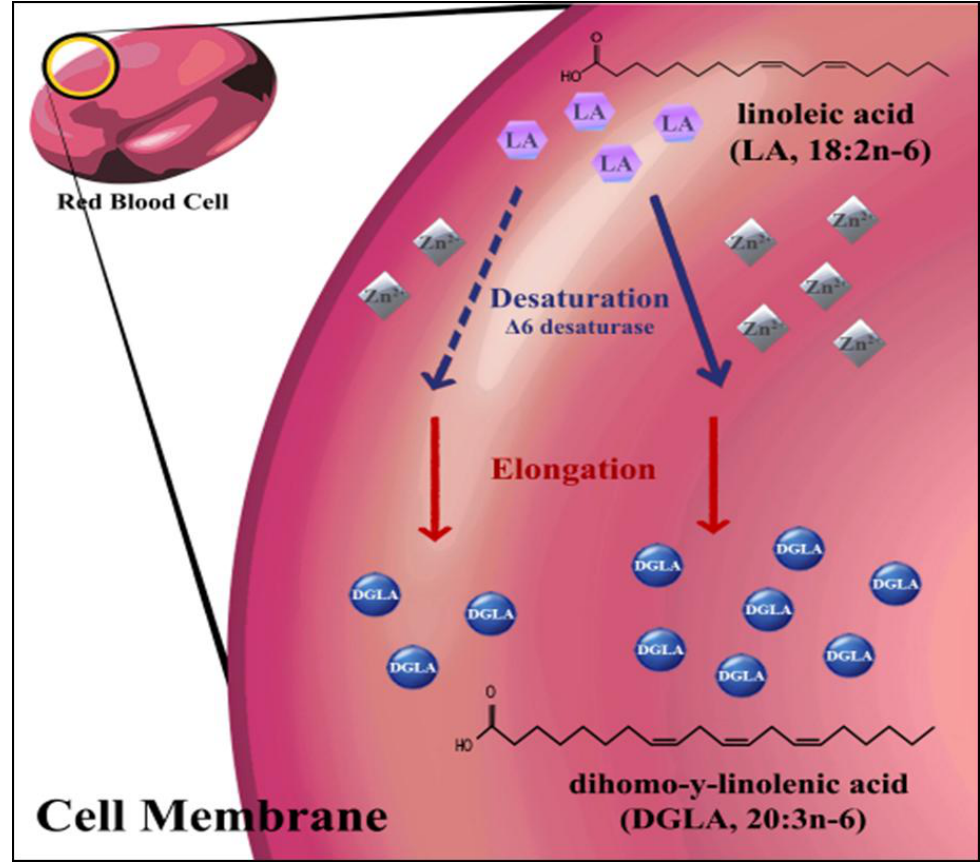
Figure 1. A truncated schematic of the LA to DGLA fatty acid pathway within the erythrocyte membrane. Lack of dietary zinc (broken line), needed for Δ 6 desaturase enzyme function, will impede conversion of reactant (LA) to product (DGLA) and will result in an increased ratio of LA to DGLA. This ratio may be a sensitive biomarker to identify endogenous zinc